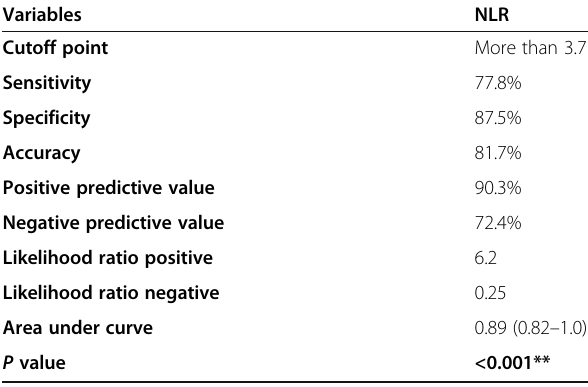
Table 4 Diagnostic performance of neutrophil/lymphocyte ratio in the prediction of unfavorable outcomes